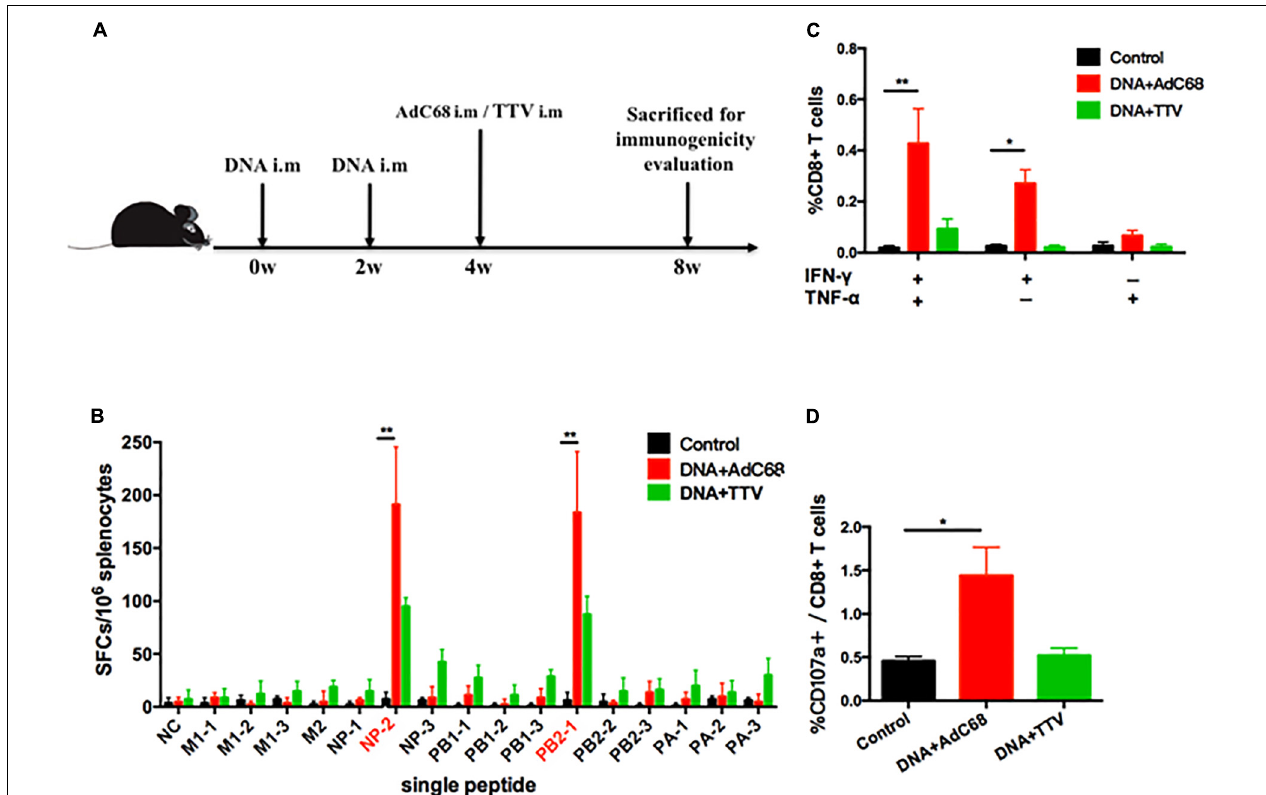
FIGURE 2 | Influenza-specific T-cell immune responses raised by DNA prime-viral vectored vaccine boost. (A) Schematic representation of immunization regimens. (B–D) Cellular responses elicited in vaccinated mice. Splenocytes of vaccinated C57 mice were isolated 4 weeks after vaccination and subjected to both IFN- γ ELISpot assay (B) and intracellular cytokine staining assay (C,D) . The IFN- γ ELISpot assays were performed in response to stimulation with a single IAV virus-specific peptide and described as numbers of spot forming cells (SFCs) per 10 6 splenocytes. A total of 16 peptides were tested ( Table 1 ). The intracellular cytokine staining assays were performed upon stimulation with a peptide pool composed of all the 16 peptides, and represented as the percentage of CD8 + T cells that were single positive or double positive for IFN- γ , TNF- α , and CD107a expression. All experiments were carried out in triplicate; the error bars are represented as SDs. ∗∗ p < 0.01; ∗ p < 0.05, t